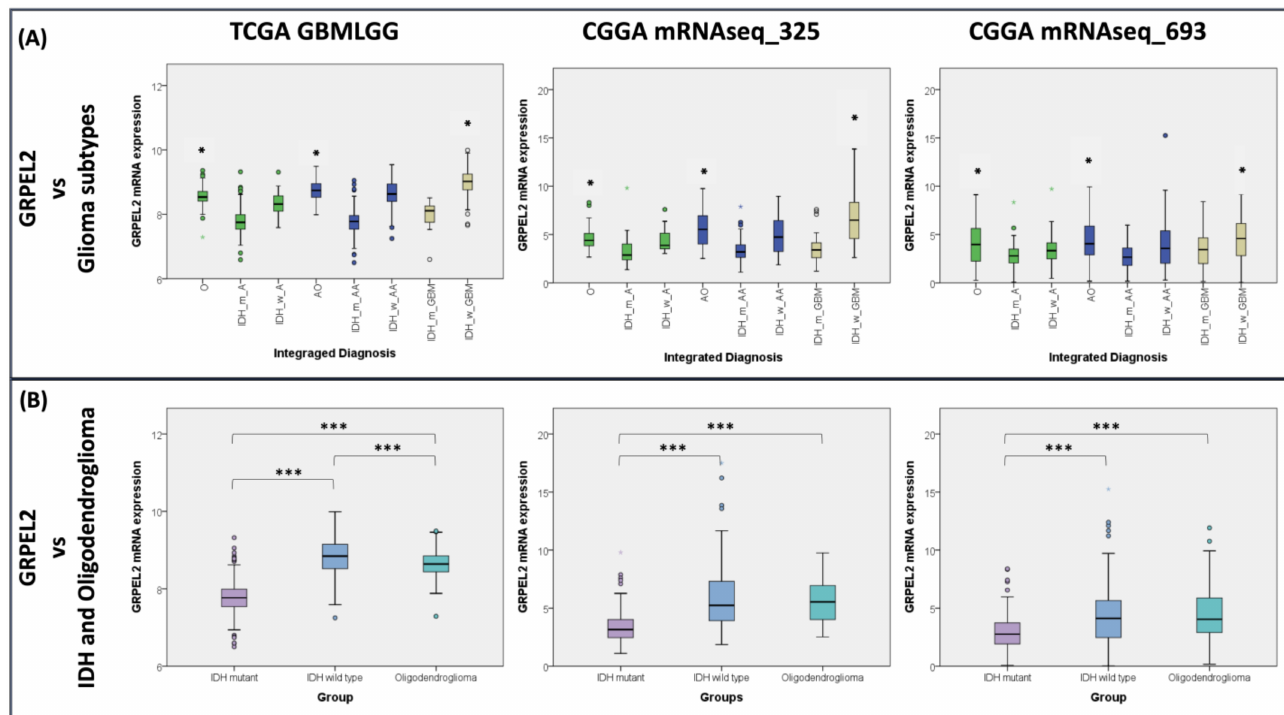
Figure 2. Elevated GRPEL2 expression correlated with oligodendroglial differentiation and IDH status. ( A ) The boxplots showing GRPEL2 mRNA expression correlate with phenotypes of oligodendroglioma (O), diffuse astrocytoma (A), anaplastic oligodendroglioma (AO), anaplastic astrocytoma (AA), and GBM in the TCGA and CGGA datasets. IDH status annotation: W (wide type) and M (mutant). * p < 0.05. ( B ) Graphs of GRPEL2 mRNA expression level association with oligodendroglial differentiation and IDH status in the TCGA and CGGA datasets. *** p <